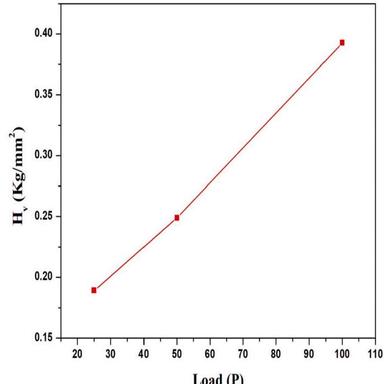
Variation of load P verses Hv for UGA crystal.